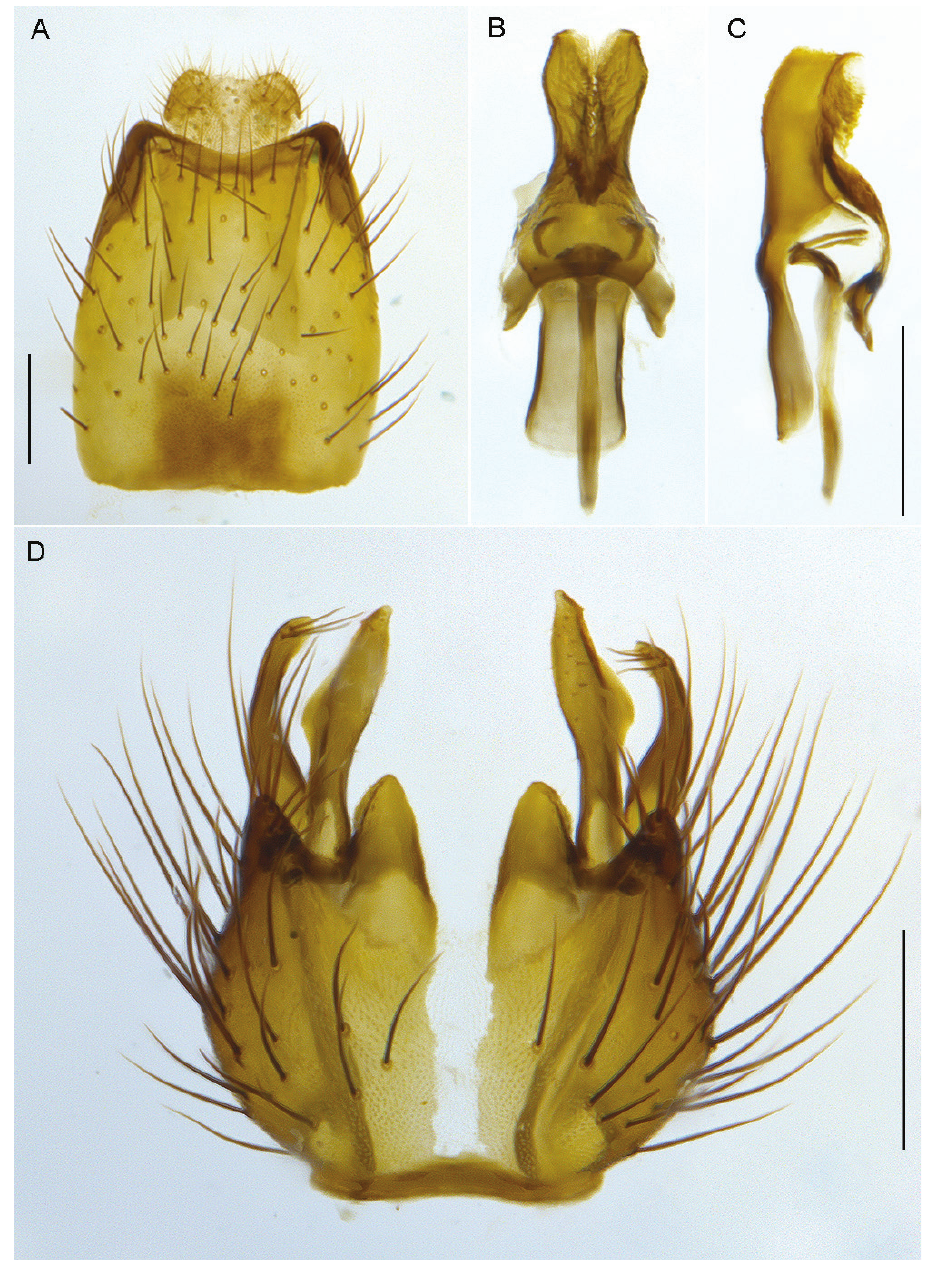
Figure 26. Zelothrix yeatesi sp. n.: Male genitalia: A Epandrium, dorsal view B Aedeagus, dorsal view C Same, lateral view D Gonocoxites, ventral view (epandrium and aedeagus removed). Scale line: 0.2